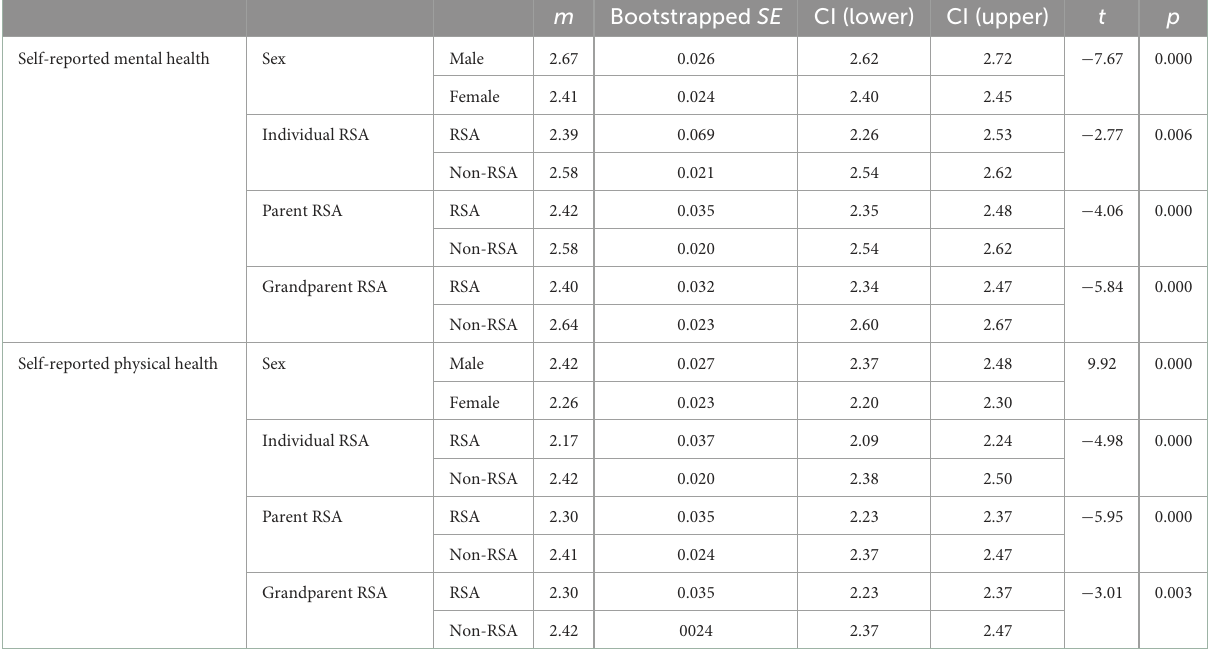
TABLE 2 Independent t -tests of self-reported mental and physical health of individual, parent, and grandparent RSA. m Bootstrapped SE CI (lower) CI